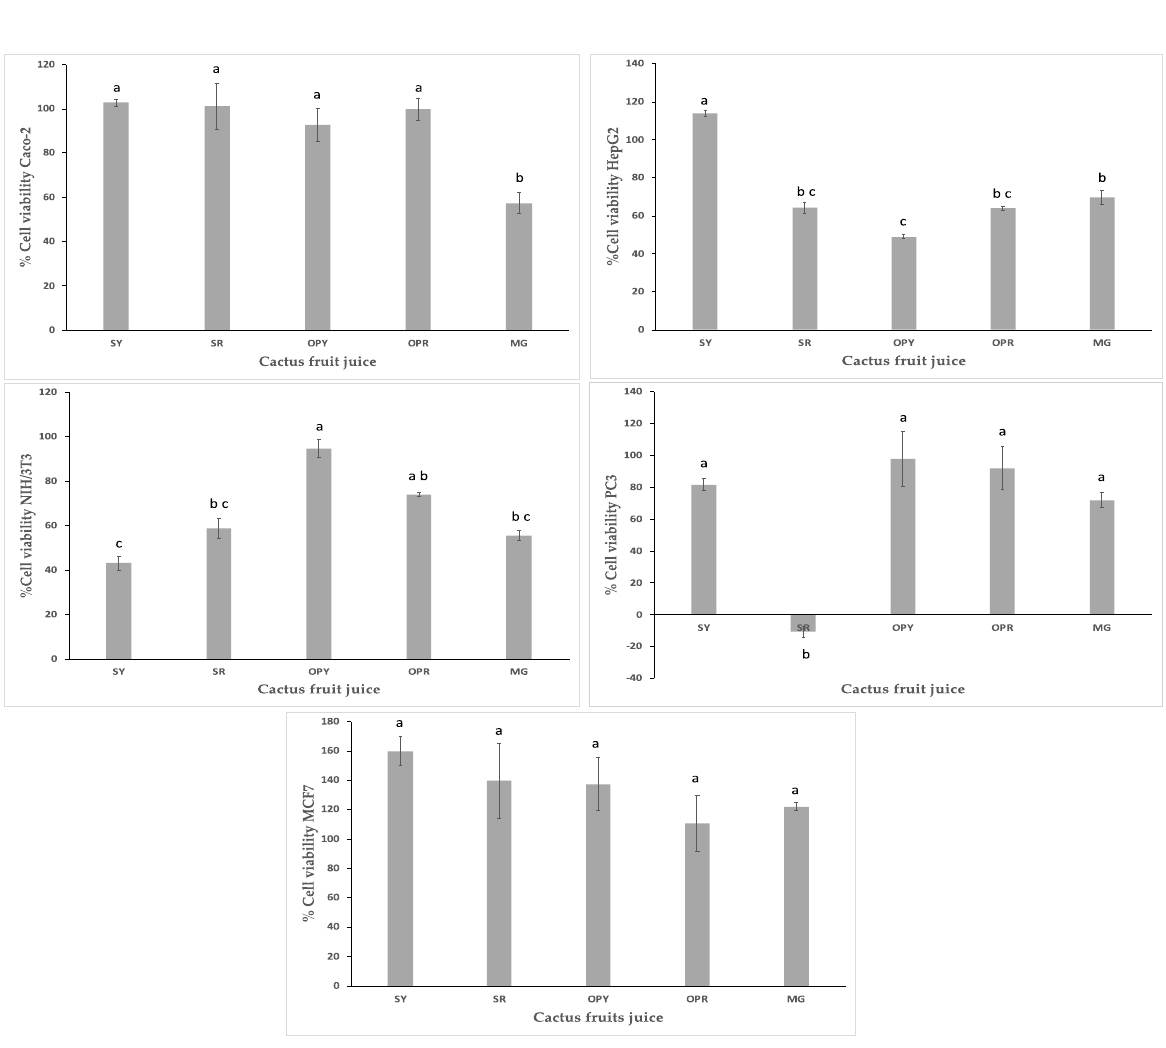
Figure 2. Cell viability of Caco-2, HepG2, NIH/3T3, PC3, and MCF7 cell-lines treated with cactus clarified juices at 2% v / v . Cell viability was expressed in terms of percentage of living cells relative to the non-treated control. Results were expressed as means of triplicate experiments and error was expressed as Standard error of mean (SEM). Different lowercase letters (a–c) indicate a statistical significance difference ( p < 0.05). Stenocereus pruinosus yellow fruit (SY), Stenocereus pruinosus red fruit (SR), Opuntia ficus-indica yellow fruit (OPY), Opuntia ficus-indica red fruit (OPR), and Myrtillocactus geomettizans fruit